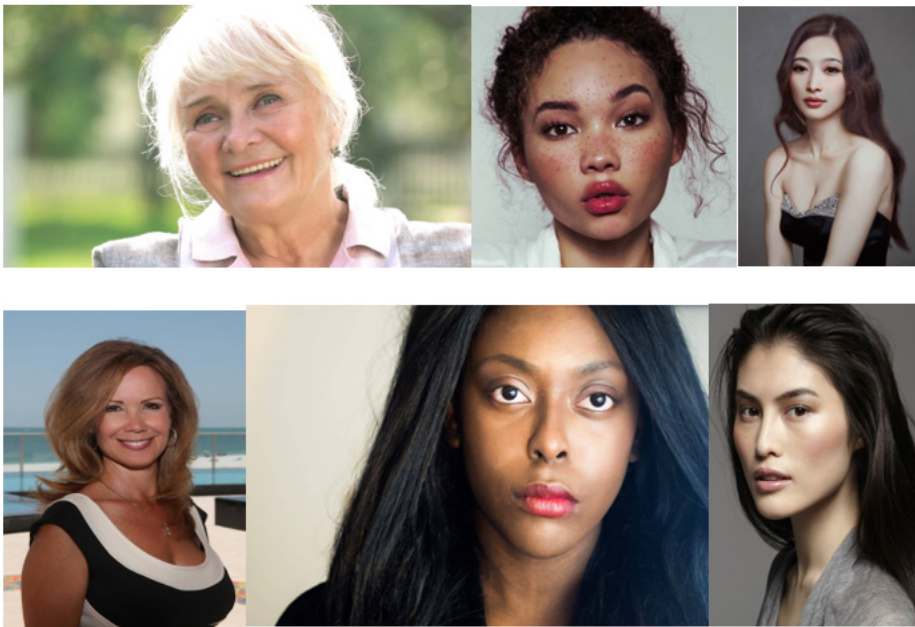
Figure 11. Six random images of women with varying ages, ethnicities, image background, dimensions, poses, and zoom level taken from the dataset found in [41].